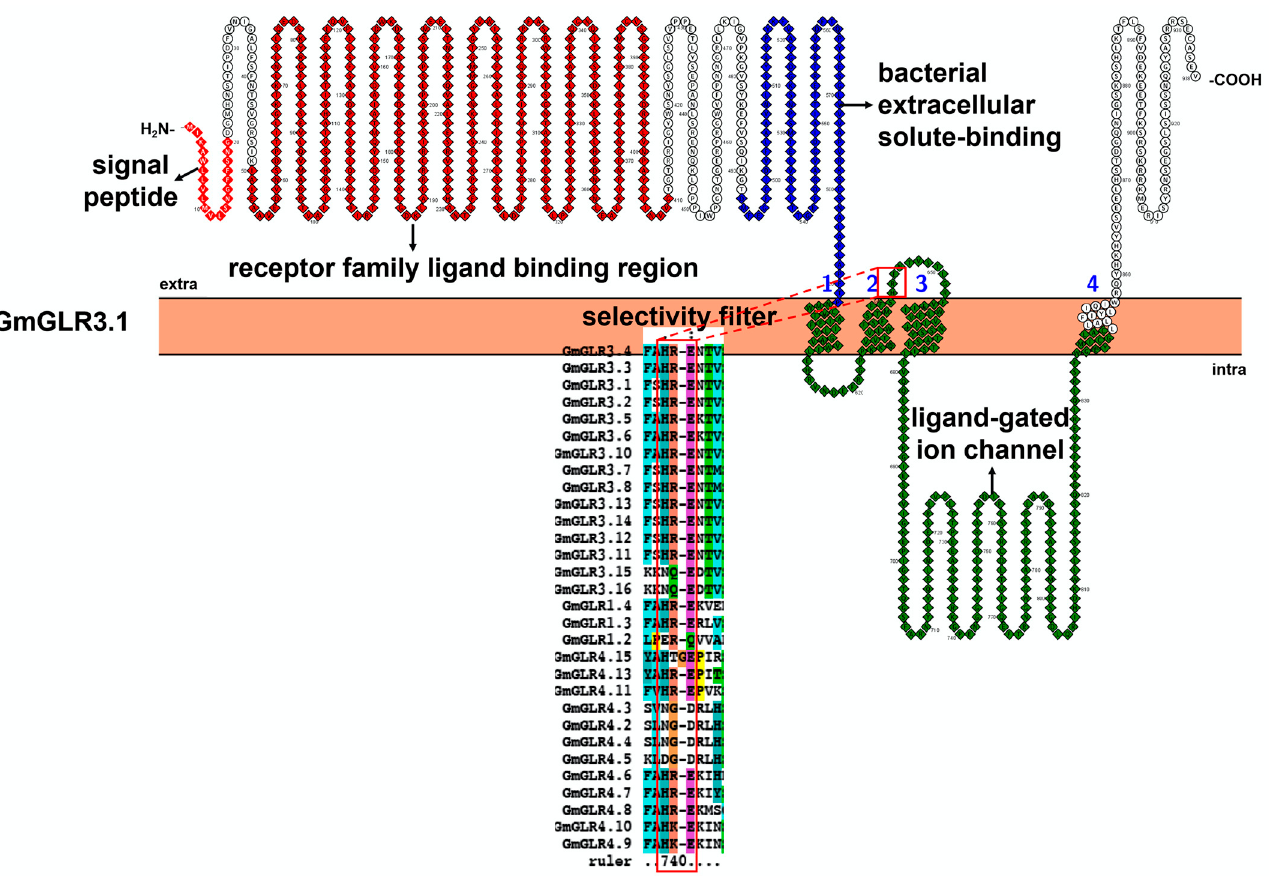
Figure 6. Topology model and homology analysis of soybean glutamate receptor-like (GLR). The red box in the topology model represents the conserved selectivity filter motif in the protein se- quence alignment. The protein topology figure was constructed by using Protter [25]. The protein sequences were aligned by using ClustalX1.83 (http://www.clustal.org/download/, accessed on 17 October